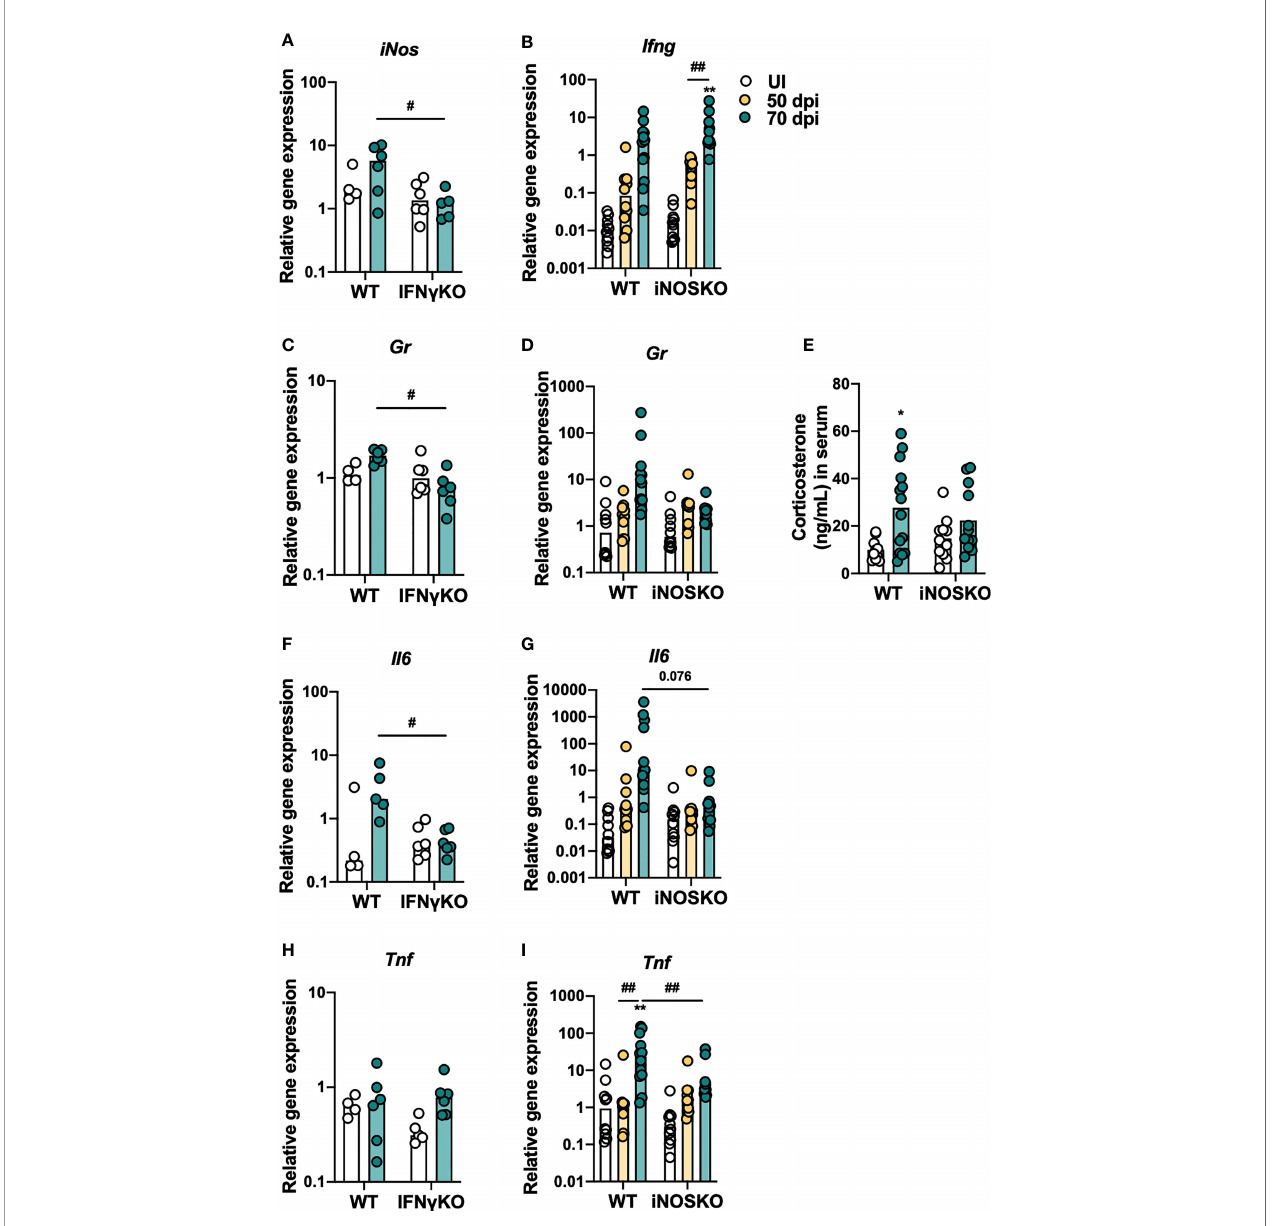
FIGURE 5 | M. avium strain 25291 infected IFN g KO and iNOSKO mice present a milder in fl ammatory pro fi le in the thymus than WT infected mice. RNA expression levels in the thymus of WT, IFN g KO and iNOSKO mice uninfected (white) or infected with M. avium strain 25291 for 50 (yellow) or 70 (teal) days. (A) iNos ; (B) Ifng ; (C, D) Gr ; (F, G) Il6; and (H, I) Tnf. (E) Basal corticosterone levels in the serum of WT and iNOSKO mice uninfected (white) or infected with M. avium strain 25291 for 70 days (teal). Bars represent the median for all graphs except for (E) where mean is represented; for (A, C, F, H) from 4 to 6 mice per group from one experiment; for (B, D, E, G, I) from 10 to 12 mice per group from two pooled independent experiments. Statistically signi fi cant differences were accessed by 2-way ANOVA followed by Tukey ’ s multiple comparisons test and marked between uninfected and infected groups as: * p < 0.05, ** p < 0.01; and between infected groups as: # p < 0.05, ## p < 0.01. For p -values between [0.05; 0.10], their values are represented in the graphs. UI stands for uninfected. dpi stands for days post